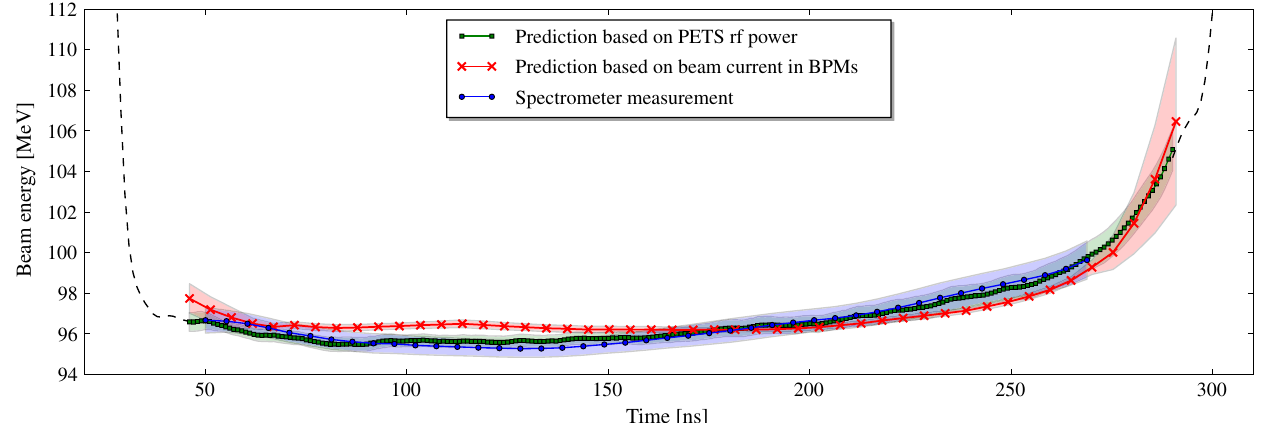
FIG. 8. Comparison between measured mean deceleration and deceleration predicted from measured beam current and PETS rf power. The curves with markers represent the average values over the data series, while the corresponding colored bands show the standard deviations. The predictions are only shown where the multibunch form factor could be calculated. Outside of this, we show the remaining signal based on the PETS rf power for reference, as a black stapled